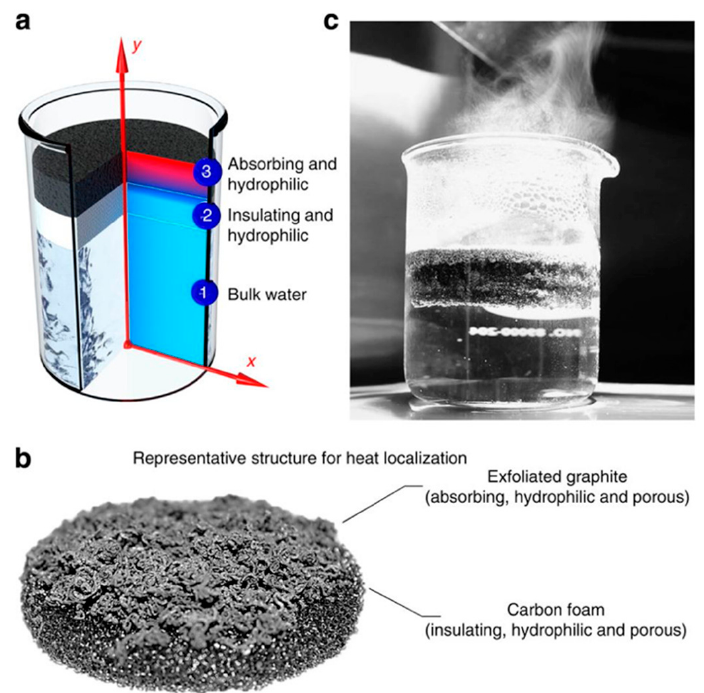
Figure 11. ( a ) A schematic structure and temperature distribution of a capillary-driven water ascension (CDWA) system. ( b ) The double layer structure consisting of capillary channels and evaporation plate, both being hydrophilic to drive the capillary ascending of water to the surface. ( c ) Enhanced steam generation under the solar illumination [64].